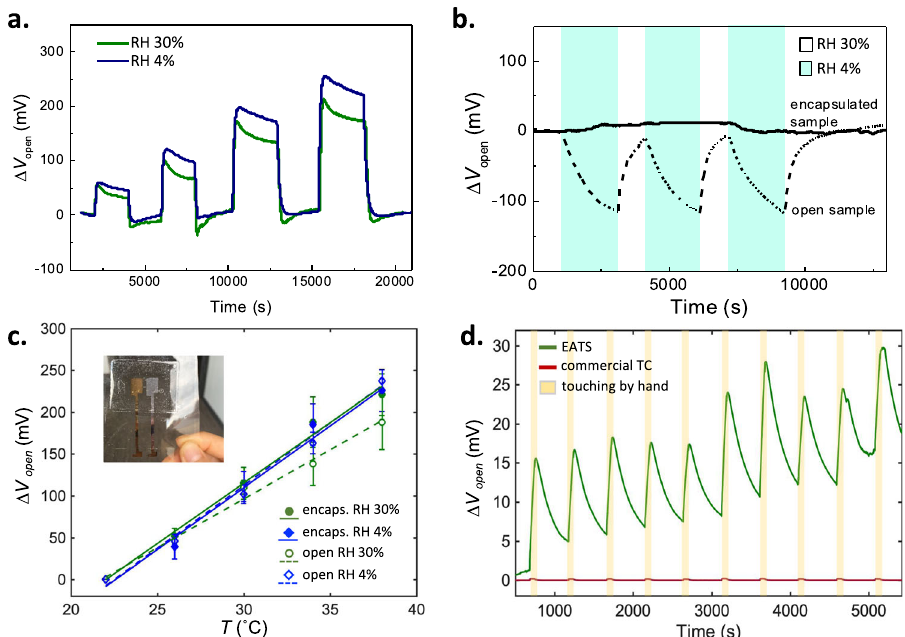
Fig. 4 Humidity response of EATS and mitigating the effect by encapsulation. a Temporal changes in open-circuit voltage of an EATS on a glass substrate during heat cycles (from 22 to 26 °C, 30, 34, and 38 °C, respectively) at high humidity (green) and low humidity (blue). b Variation in open-circuit potential upon changes in humidity (alternating between RH = 30% and RH = 4%) at 22 °C, for an open EATS (dashed line) and for an encapsulated EATS (solid line). c Changes in open-circuit voltage versus temperature at high (green) and low (blue) humidity for open (un fi lled markers and dashed lines) and encapsulated EATS ( fi lled markers and solid lines). Each data point (error bar) represents the average value (standard deviation) from three series of measurements. The inset shows a photograph of an encapsulated EATS device. d Change in open-circuit voltage generated by an encapsulated EATS (green) and a commercial TC (red) upon touch by a human hand (yellow shaded (RH = 30%, green fi lled markers in Fig. 4c) and 13.4 mV K − 1 at low humidity (RH = 4%, blue fi lled markers). The open markers and dashed lines in Fig. 4c correspond to three measurements from two open EATS devices (without encapsulation). These open EATS devices exhibited different sensitivity at different humidity (11.5 mV K − 1 at RH = 30% and 13.8 mV K − 1 at RH = 4%), while